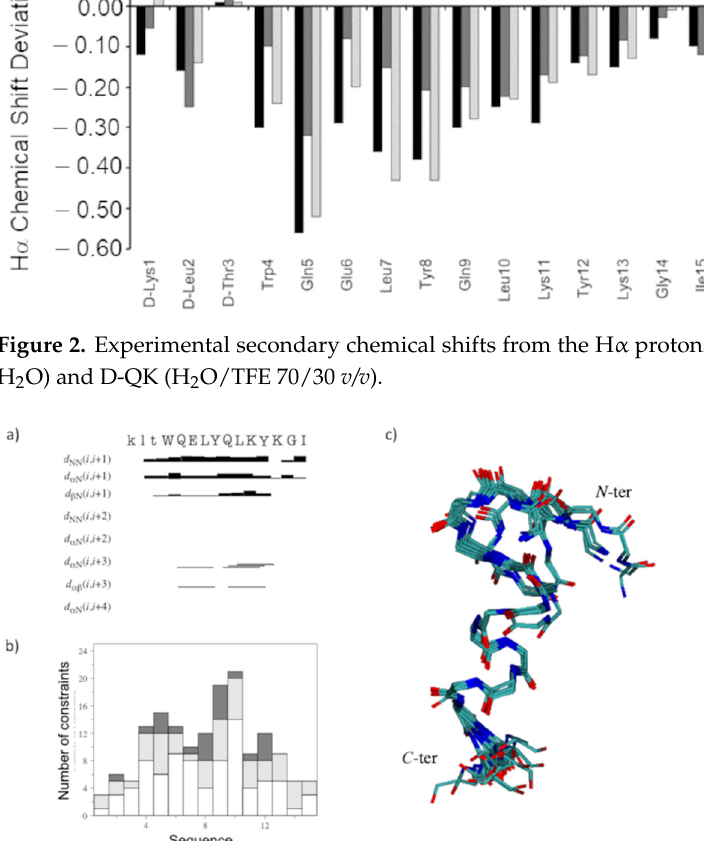
Figure 4. (a) Superposition of QK (red) and representative structure of D-QK (cyan) in aqueous solution (RMSD (N, Ca, C’(5–12) = 3.00 ± 1.5 Å) and ( b ) representative structure of D-QK in 30% TFE (RMSD (N, Ca, C’(5–12) = 0.46 ± 0.5 Å). The molecules are represented as ribbon. Because the addition of TFE leads to a more structured conformation of the peptide according to the CD spectra, the NMR characterization of the D-QK was also performed in 30% TFE. The identification of spin systems and assignment of individual resonances for D-QK together to coupling constants (Tables S1 and S2) were obtained as previously described for D-QK in aqueous solution. The analysis of the secondary chemical shifts for the H α protons in 30% TFE points out the presence of helical conformation encompassing the whole peptide sequence with a percentage of helical population equal to 53% (Figure 2), very close to that of QK (59%). The NOESY assignments of the D-QK showed an extensive NN (i, i + 1), α N (i, i + 3), and αβ (i, i + 3) set of cross peaks primarily observed in the 4–12 region of the peptide, as shown in Figure 5a, which confirmed the high helical